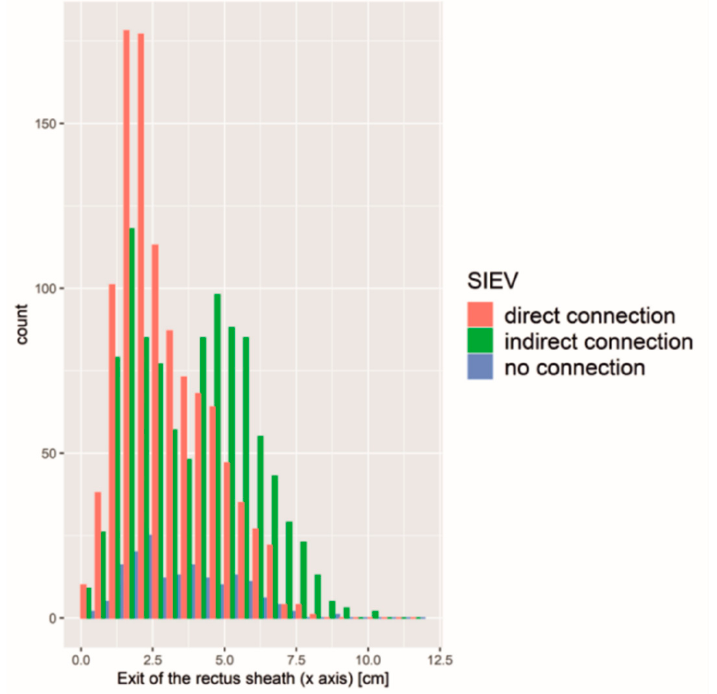
Figure 4. Absolute counts of different SIEV connection types regarding exit of the recuts sheath. Perforators close to the umbilicus were more likely connected to the SIEV.